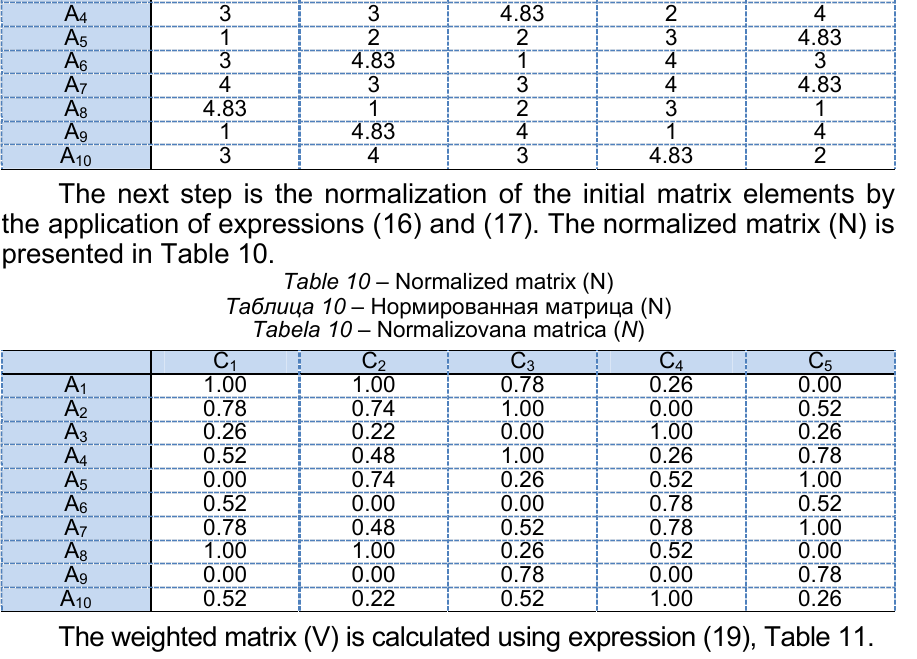
Table 11 – Weighted matrix (V) Таблица 11 – Нечеткая матрица